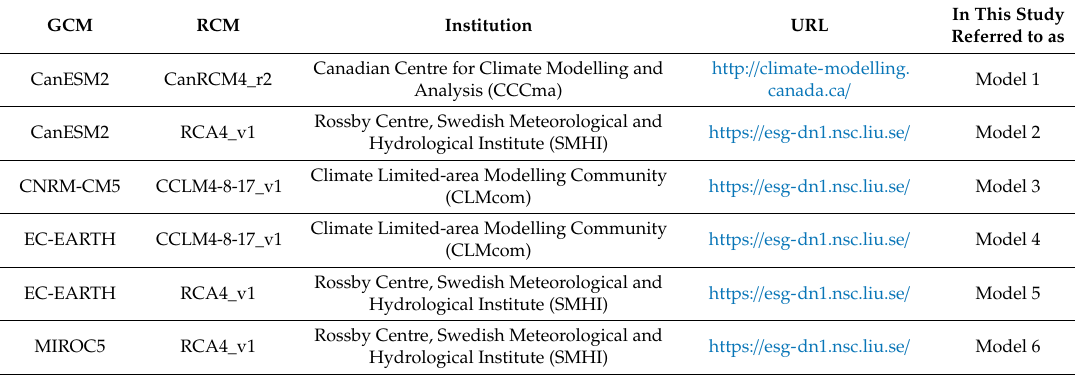
Table 2. Overview of the Regional Climate Models (RCMs), their driving Global Climate Models (GCMs), and the assigned naming for the model combination within this